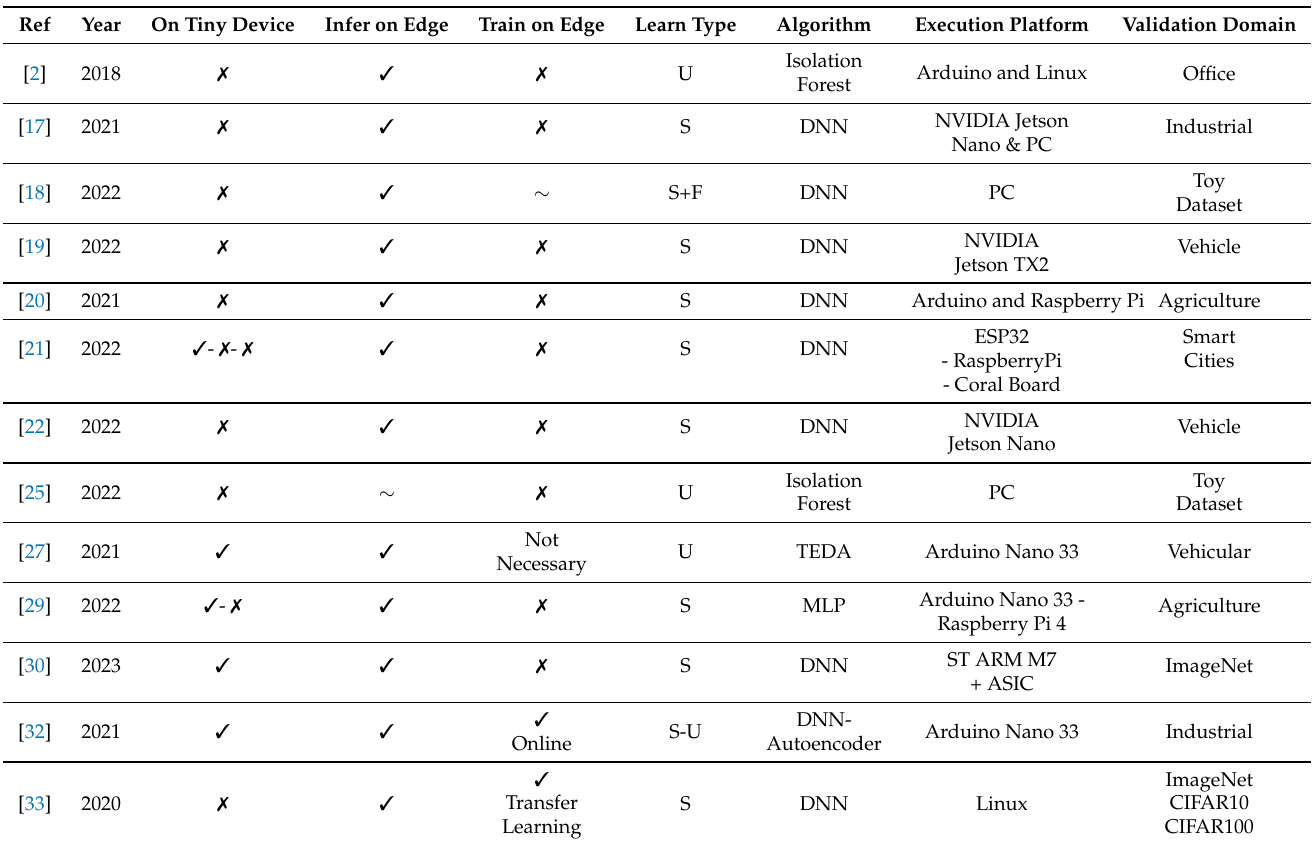
Table 1. Summary of related works ( [13] is our previous work). Legend: (cid:51) : feature available, (cid:55) : feature not available, ∼ : feature partially available. (cid:51) - (cid:55) : feature available on the first hardware platform, not available on the second hardware platform. S: Supervised Learning, U: Unsupervised Learning, F: Federated Learning. Learn Type Algorithm Execution Platform Validation Domain Office